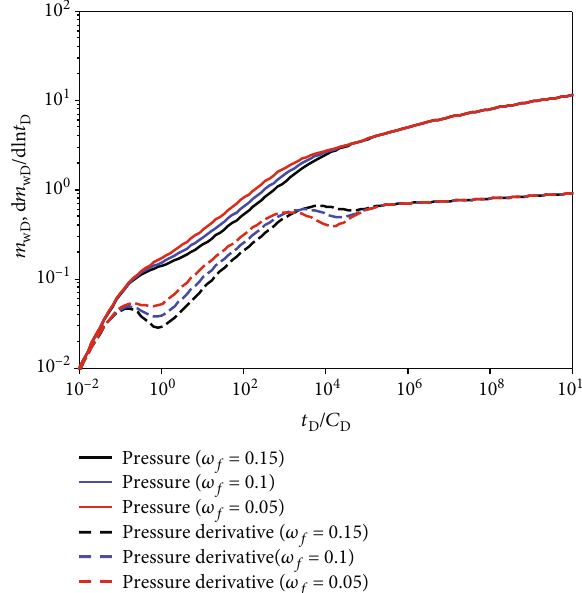
Figure 6: E ff ect of dimensionless permeability modulus, γ type curves.